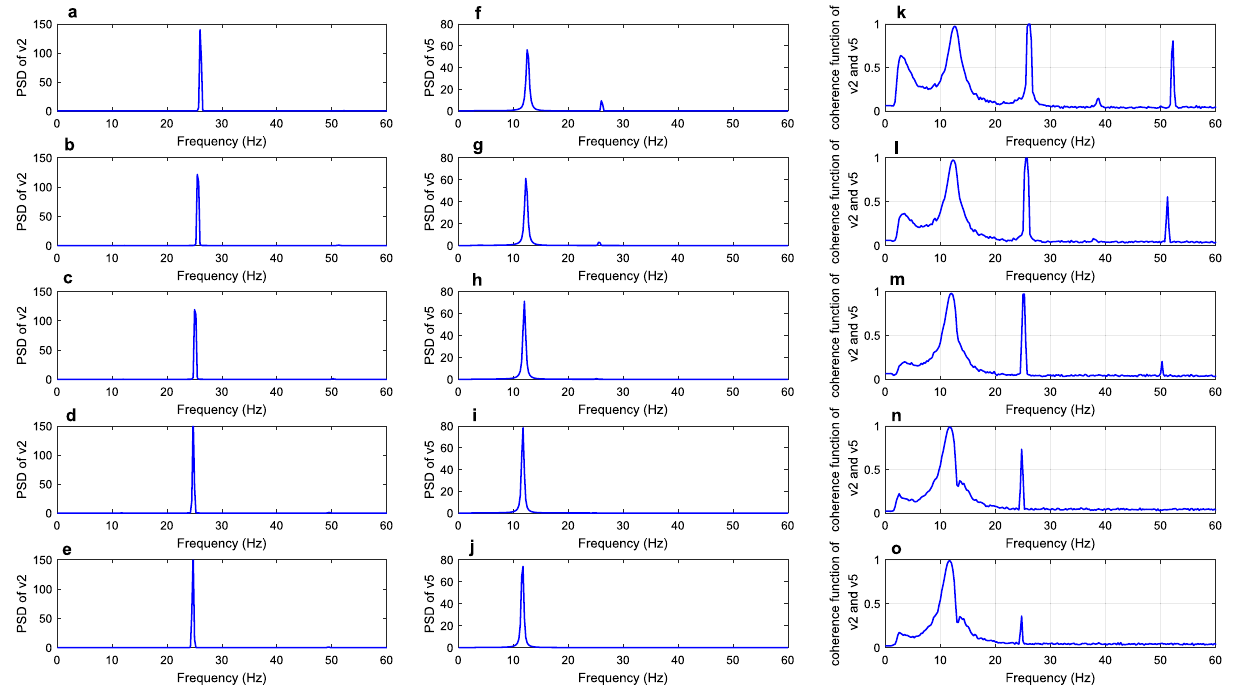
Figure 7. The first and second columns are PSD of areas v2 and v5, respectively. The coherence function between the two areas was delineated in the third column. From top to bottom, the parameters of long synaptic projection from v2 to v5 were in turn = 50, 35, 20, 5 and